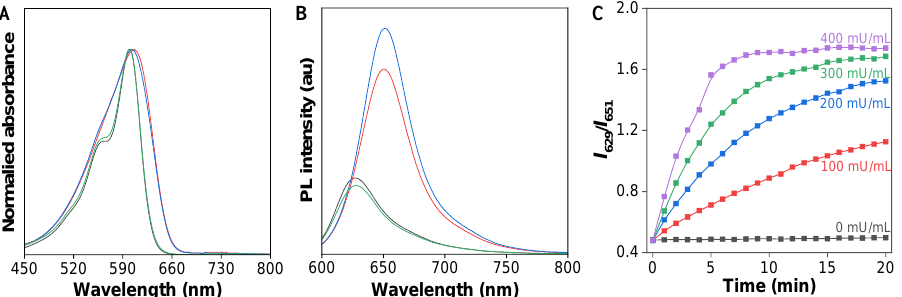
Figure 2. ( A ) Normalized absorption and ( B ) PL intensity spectra of TCFIS (black), TCFISE (blue), TCFISE + CaE (green), and TCFIS + BNPP + CaE (red) in DMF/PBS (3/7, v / v , pH = 7.4). ( C ) The relative PL intensity ratios ( I 629 / I 651 ) of TCFISE in the presence of different amounts of CaE (0 – 400 mU/mL) as a function of incubation time. Concentrations: TCFISE and TCFIS, 5 μM; CaE , 1 U/mL; BNPP, 1 mM. λ ex = 575 nm.